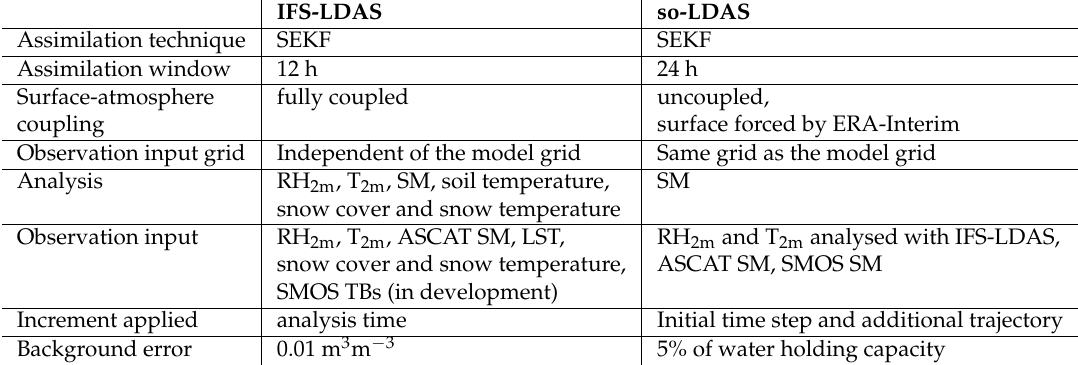
Table 2. Comparison of the IFS Land Data Assimilation System (LDAS) and the surface-only LDAS. IFS-LDAS so-LDAS Assimilation technique SEKF SEKF Assimilation window 24 h Surface-atmosphere fully coupled uncoupled, coupling surface forced by ERA-Interim Observation input grid Same grid as the model